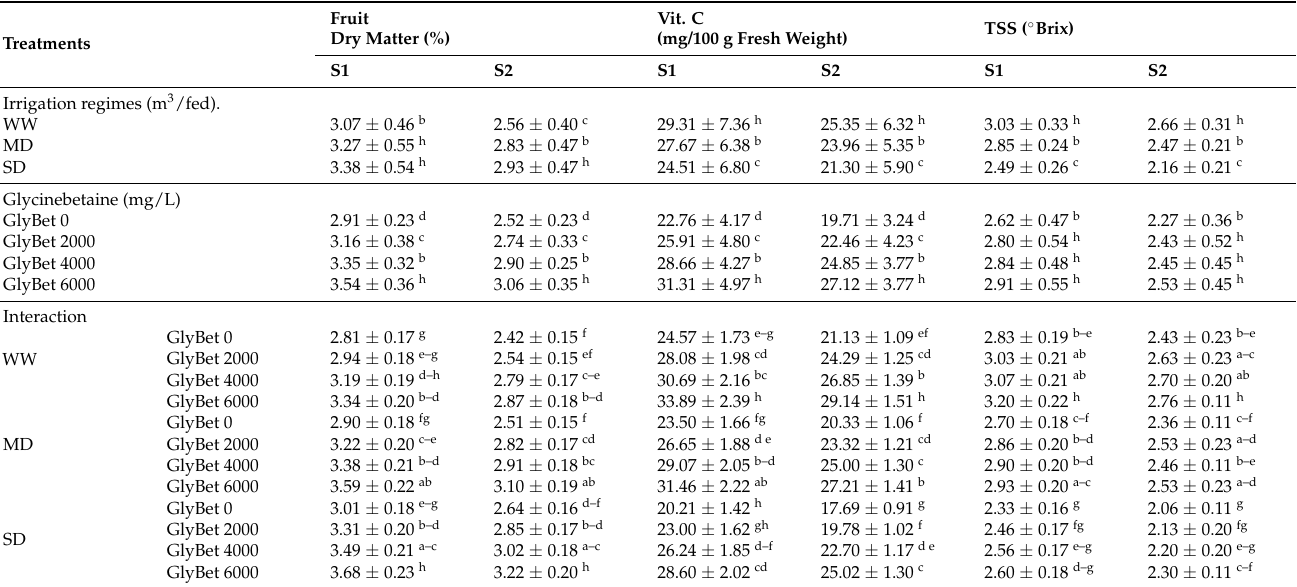
Table 6. Some fruit quality trials of cucumber as affected by GlyBet concentration, irrigation regimes, and their interactions in both seasons—2020 and